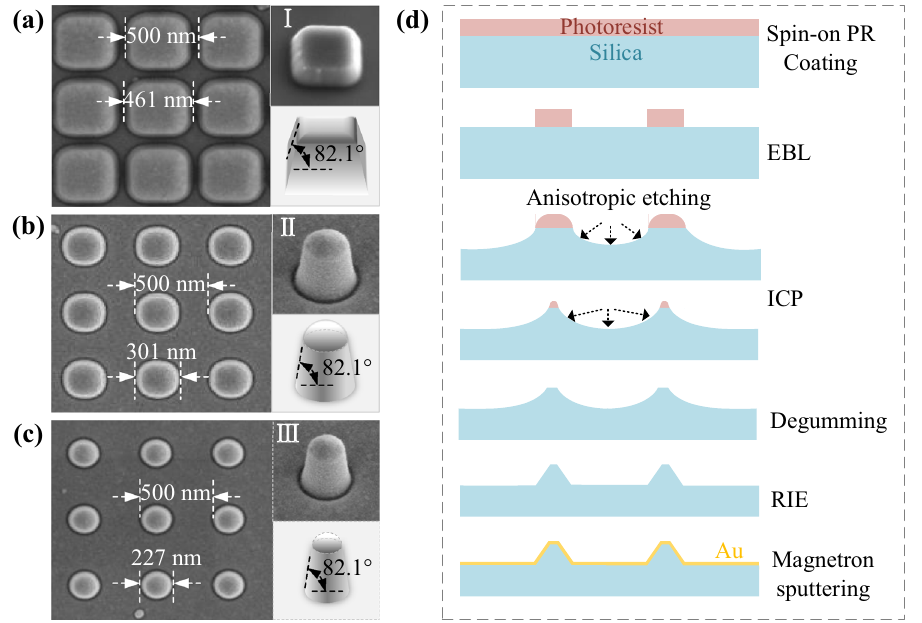
Figure 2. SEM micrographs of several GGNCT arrays with different morphology and the process flow. The main structural parameters ( S T , D 1 , θ ) of the GGNCTs are as follows: ( a ) (500, 461, 82.1°), ( b ) (500, 301, 82.1°), and ( c ) (500, 227, 82.1°). ( d ) The key fabrication processes including typical EBL, ICP, and